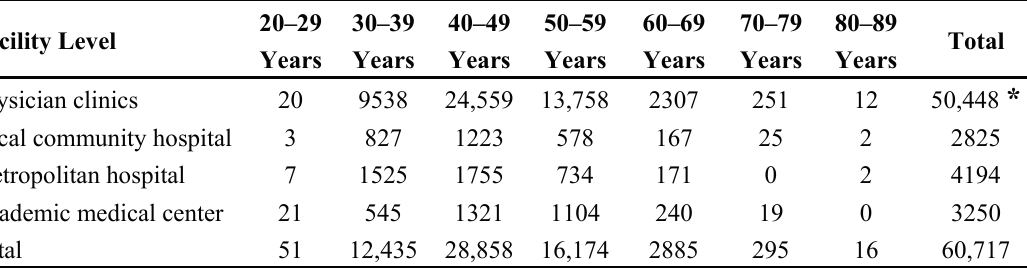
Table 2. Pediatricians’ age affiliation, stratified according to healthcare facility accreditation, data from Taiwan’s National Health Insurance in 2012 (sampling rate: 1/500). 20–29 30–39 40–49 50–59 60–69 70–79 80–89 Facility Level Total Years Years Years Years Years Years Years Physician clinics 20 9538 24,559 13,758 2307 251 12 50,448 * Local community hospital 3 827 1223 578 167 25 2 2825 Metropolitan hospital 7 1525 1755 734 171 0 2 4194 Academic medical center 21 545 1321 1104 240 19 0 3250 Total 51 12,435 28,858 16,174 2885 295 16